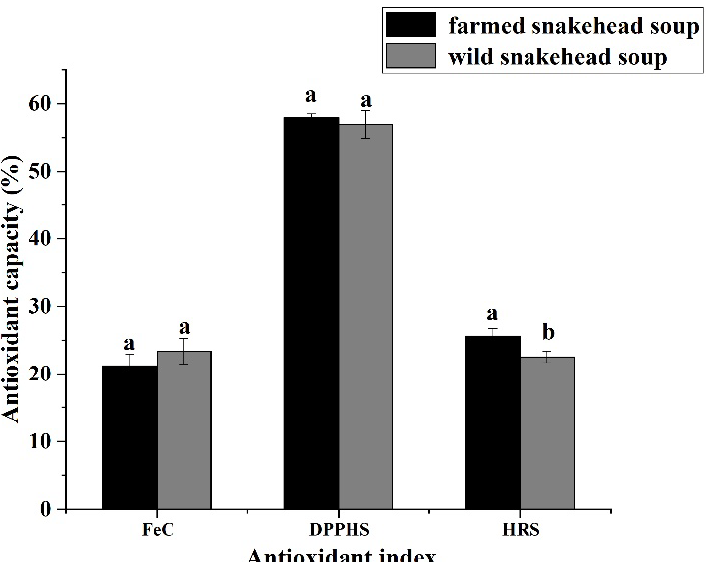
Figure 1. Antioxidant ability of soup made from farmed and wild snakehead fish. FeC: Fe2+ chelat- ing ability, DPPHS: DPPH scavenging ability, HRS: hydroxyl radical scavenging ability. Different lowercase letters indicate significant difference in antioxidant capacity between the soup made from farmed and wild snakehead fish ( p < 0.05).